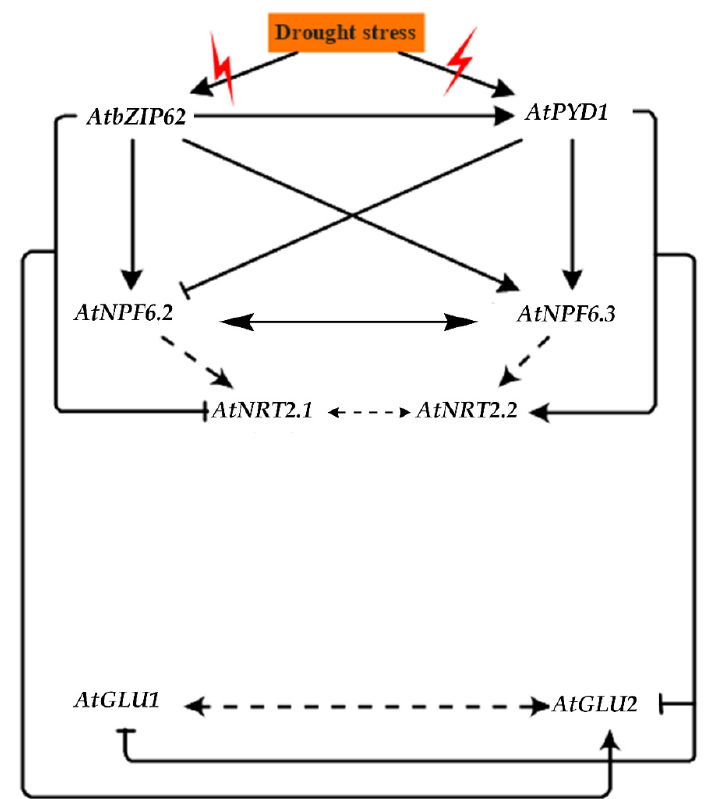
Figure 4. Signaling model of the transcriptional regulation of nitrate transporters as well as glutamate synthase-encoding genes in response to drought stress. When plants experience adverse environmental conditions, they activate signaling cascades and the appropriate defense system, which includes the induction of a wide range of drought-responsive genes, of which the transcript accumulation events are mediated by transcription factors, and their interplay determines the degree of the defense. The basic leucine zipper (bZIP) transcription factor AtbZIP62 TF is here suggested to interact with other proteins or DNA to regulate the expression of AtNPF6.2 (low-affinity NO 3 transporter), AtNPF6.3 / NRT1.1 (dual-affinity NO 3 transporter), AtNRT2.1 and AtNRT2.2 (both having a high affinity for NO 3 transport), as well as AtGLU1 and AtGLU2 (encoding glutamate synthase) under drought stress conditions in Arabidopsis. Arrows with continuous lines indicate a positive regulation (of gene expression); whereas, continuous lines with a perpendicular bar (blunt end) show a negative regulation of gene expression by our studies (current and previous). Dotted lines with an arrow at their tips suggest a possible functional interaction as predicted through in silico transcription factor binding sites analysis and protein–protein interaction, coupled with the literature. Dotted lines with arrows indicate a proposed interaction between NO 3 transport and assimilation in the literature.